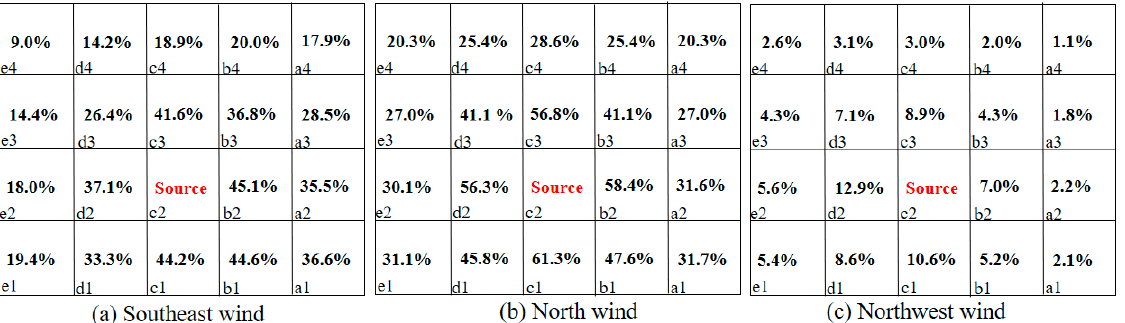
Figure 15. Interunit infectious risk p values of rooms in Q1 with room c2 as the source under three wind directions. a1,2,3,4-e1,2,3,4 represent the number of dormitory room.